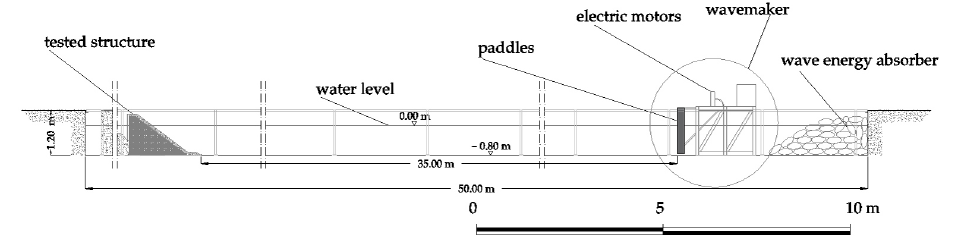
Figure 1. Wave flume setup: channel dimensions, water depth, wave board, and structure location for run